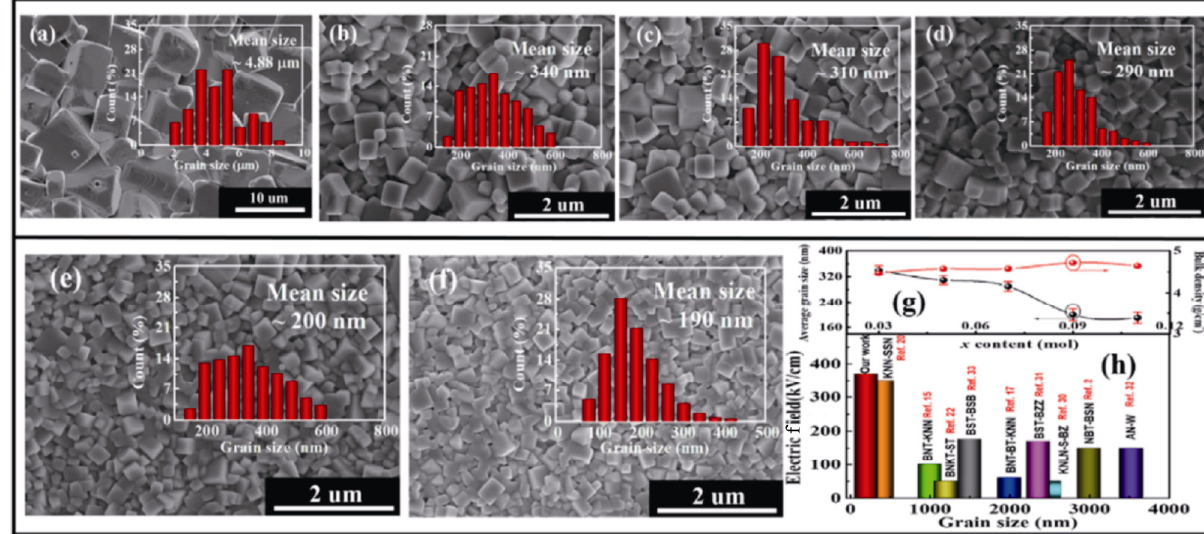
Fig. 18 SEM images and grain size distribution of the (1 − x )K 0.5 Na 0.5 NbO 3 – x SrZrO 3 ceramics: (a) x = 0, (b) x = 0.03, (c) x = 0.05, (d) x = 0.07, (e) x = 0.09, and (f) x = 0.11. (g) Dependence of the mean grain size and bulk density on the composition. (h) Comparison of E b and grain size between 0.91K 0.5 Na 0.5 NbO 3 –0.09SrZrO 3 and other typical lead-free ceramics. Reproduced with permission from Ref. [107], © Elsevier B.V.